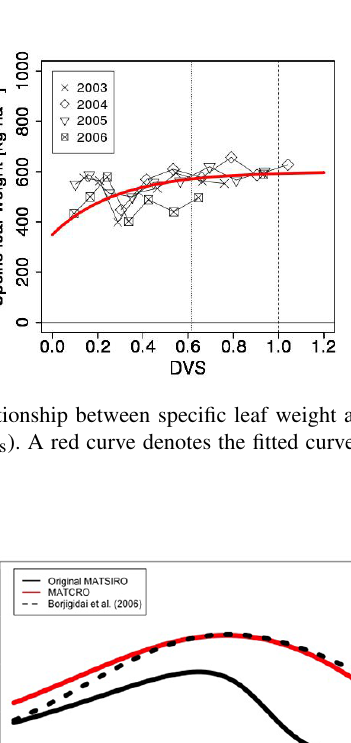
Figure 2. Partitioning ratio of glucose. Red lines are fitted. D vs indicates the development stage.